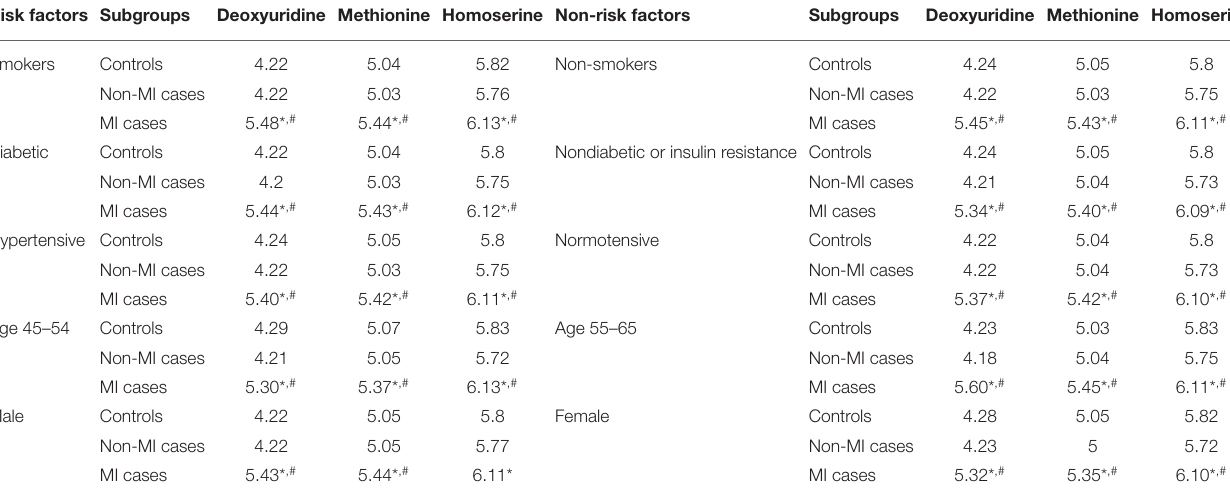
TABLE 5 | Mean of deoxyuridine, methionine, and homoserine in certain subgroups of the controls, non-MIs, and MI